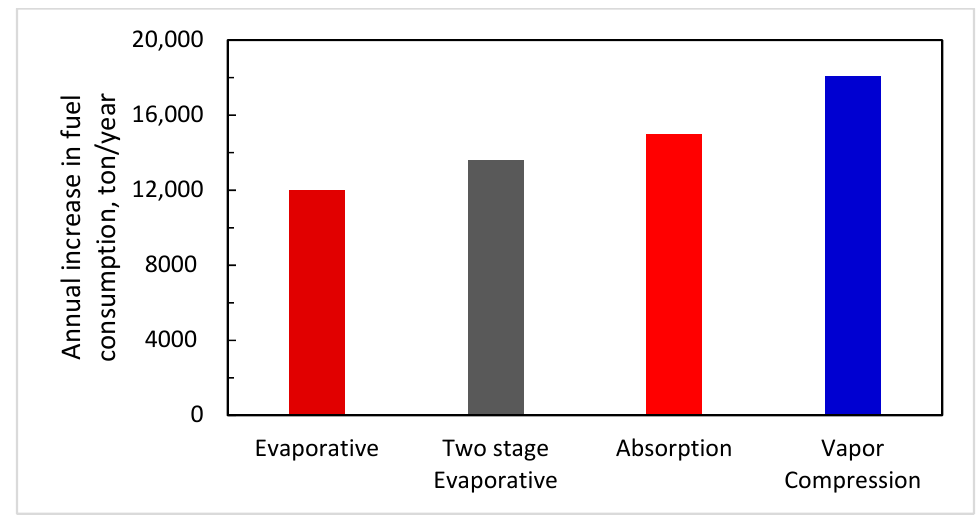
Figure 20. Annual increase in fuel consumption of different cooling systems.